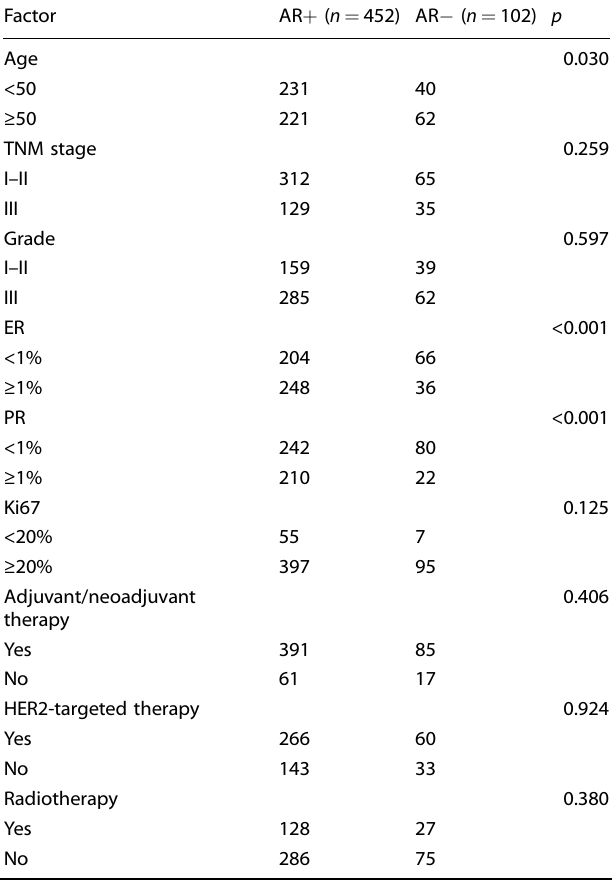
Table 1. Clinicopathological characteristics of 554 HER2 + breast IDC patients by chi-square test.